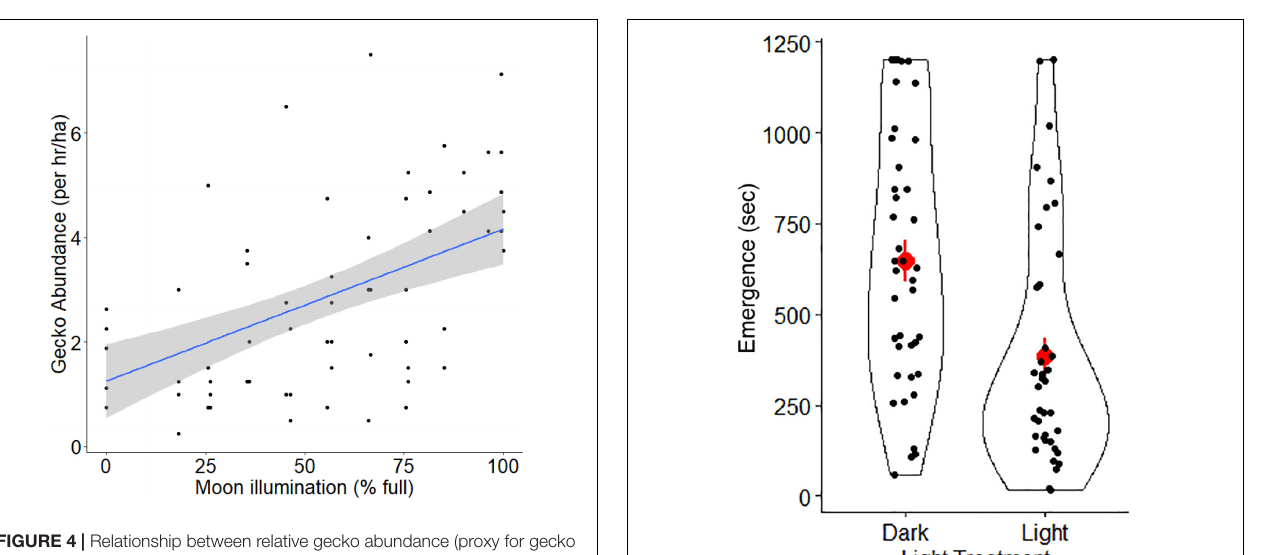
FIGURE 4 | Relationship between relative gecko abundance (proxy for gecko activity) and moon illumination. Regression line represents the best fit line (blue line) and 95% confidence interval band (gray band) from our LME model incorporating gecko abundance (standardized for search-effort) and moon illumination (adjusted for visibility during the survey).